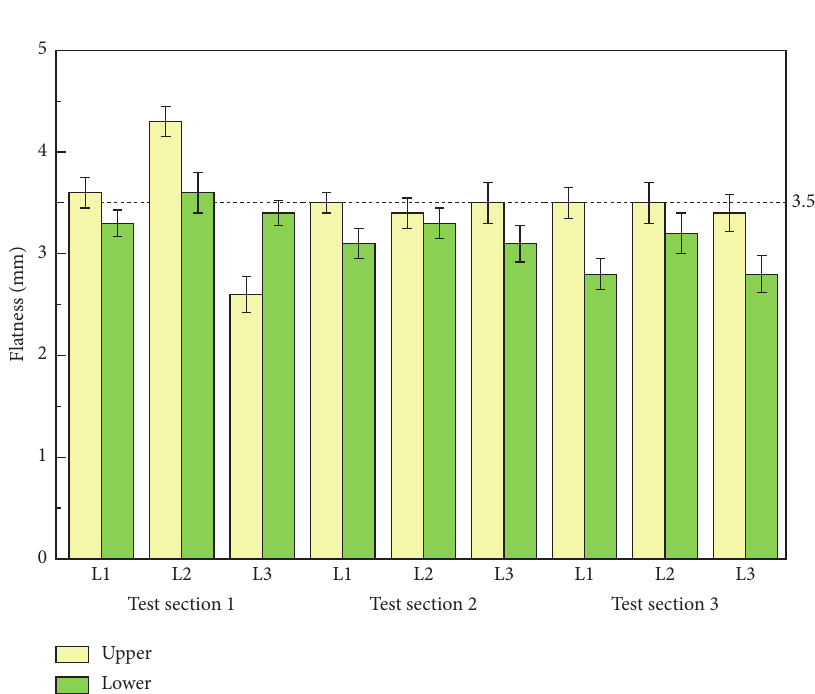
Figure 9: Longitudinal evenness test